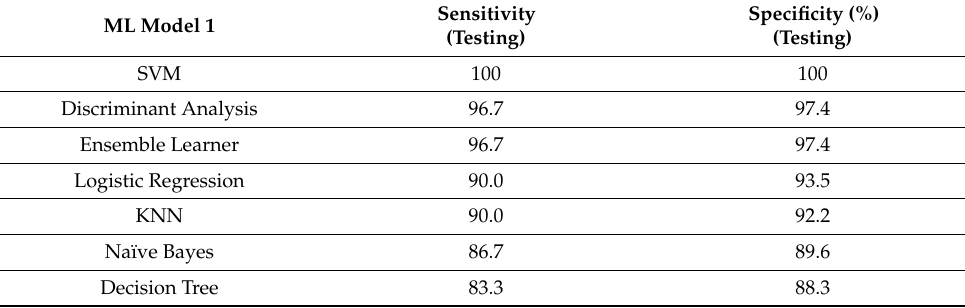
Table 7. Results of the stumble detection problem